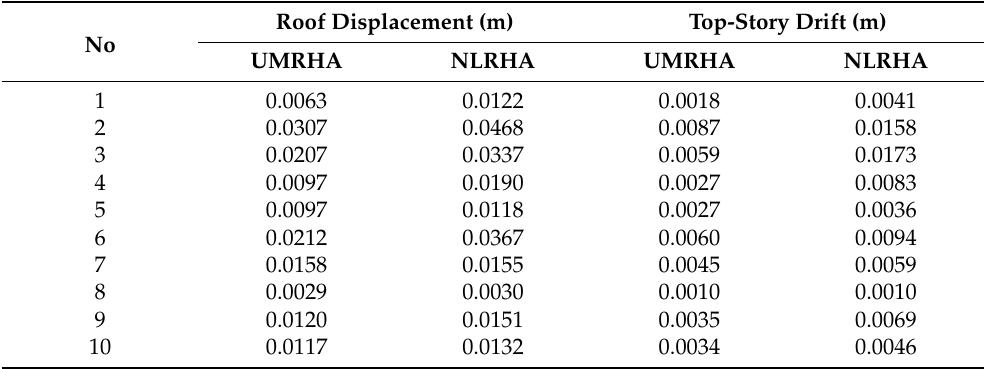
Table 10. Peak values regarding roof displacement and top-story drift of RES fully infilled frame to the selected ground motions.